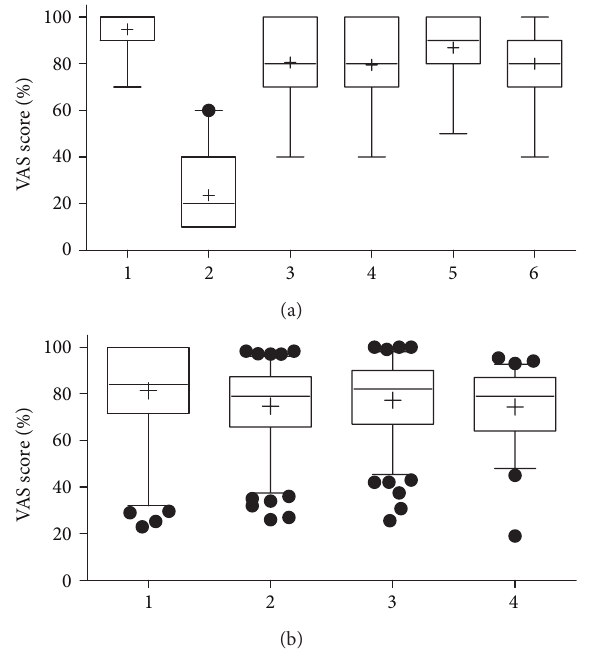
Figure 5: Self-evaluation at a discrete scale (0–10) of the online tutorial after completion, (a): of the learning success study by 𝑛 = 19 medical students using Survey Monkey. 1: organization of the E- Learning, 2: own prior knowledge in lung ultrasound, 3: